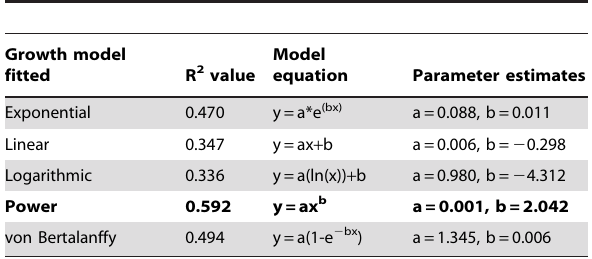
Table 1. Diagnostics and parameters for the five growth models fitted to weight at age data for the Ningaloo Octopus cyanea population.